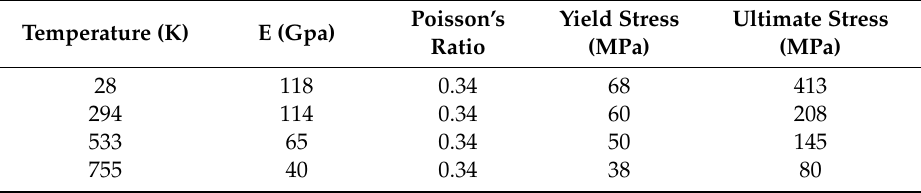
Table 7. Mechanical properties of the electrodeposited